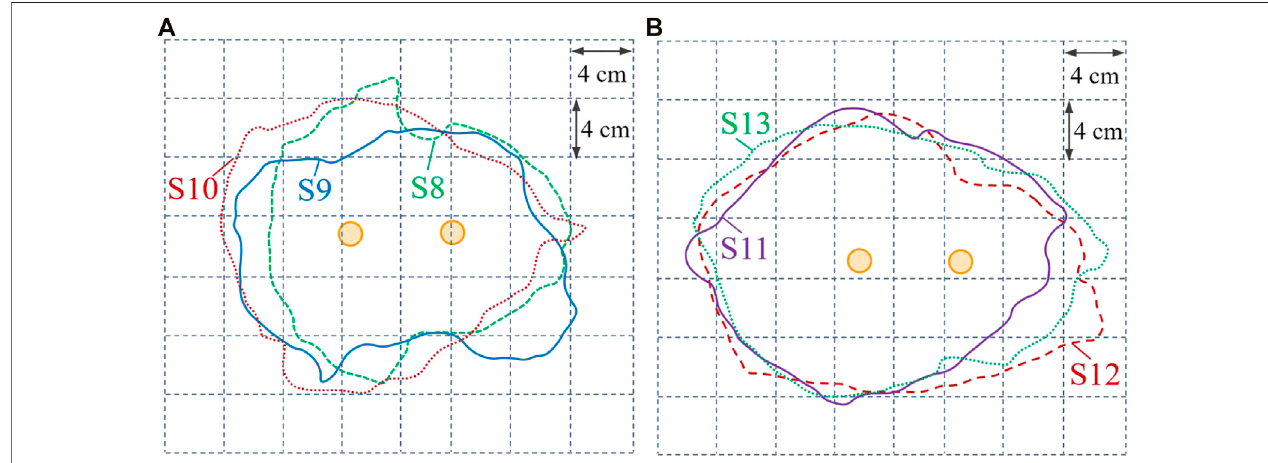
FIGURE 12 | Crater contour comparison of delay blasting. (A) Crater surface outline of S8, S9, and S10. (B) Crater surface outline of S11, S12, and S13.